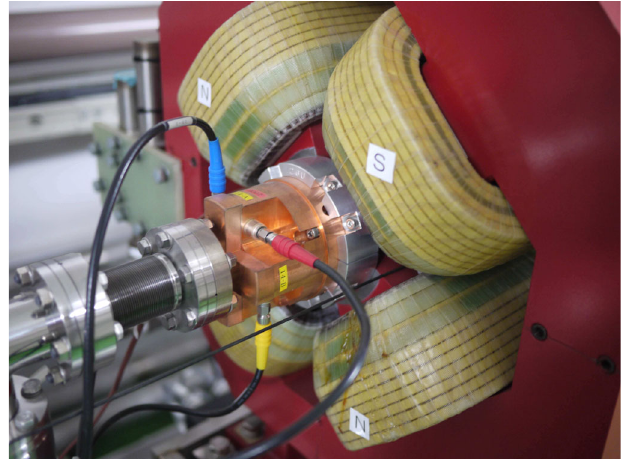
FIG. 3. C -band cavity BPM located inside quadrupole magnet (QD6FF).